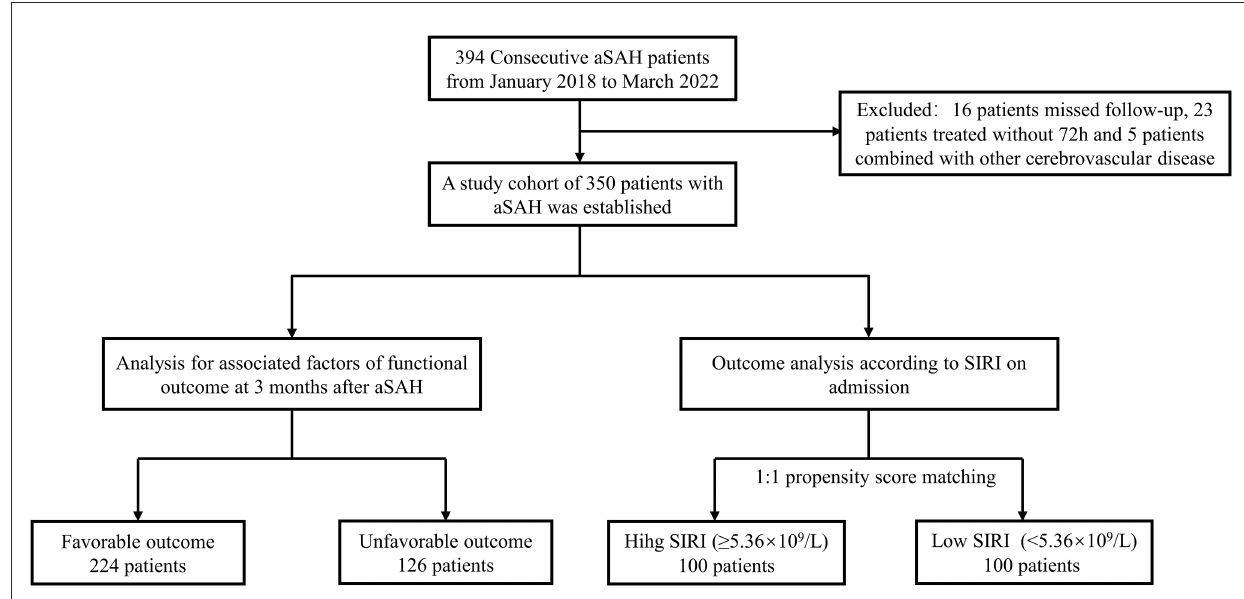
FIGURE1 Study flowchart. aSAH, aneurysmal subarachnoid; hemorrhage; SIRI, systemic inflammatory response